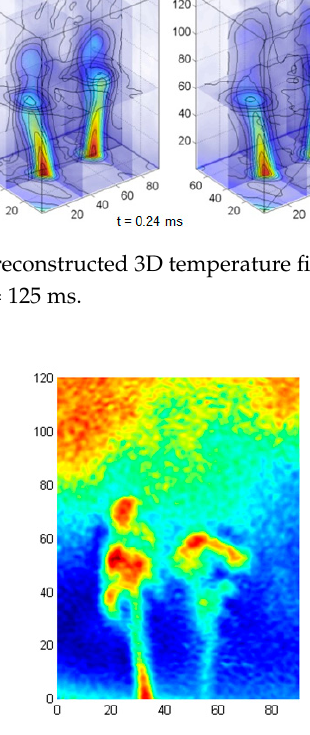
Figure 9. The fluctuation component R , representing the amount of random fluctuations of the SJ.